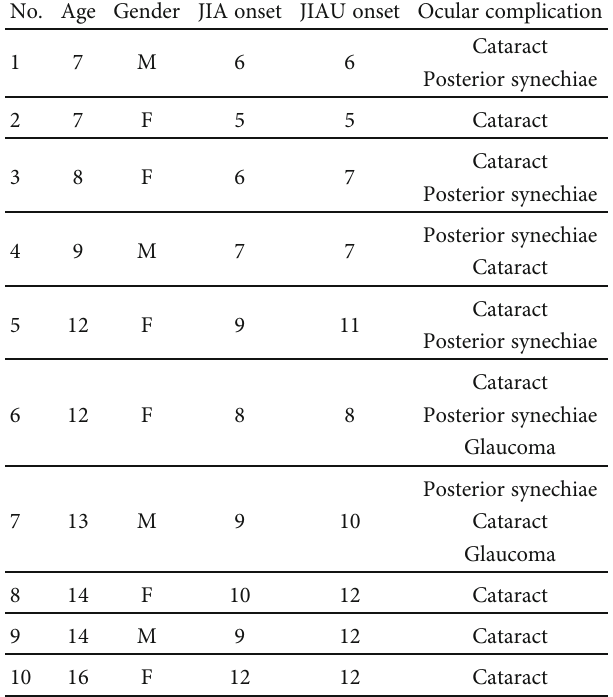
Table 2: Information of the ANA-